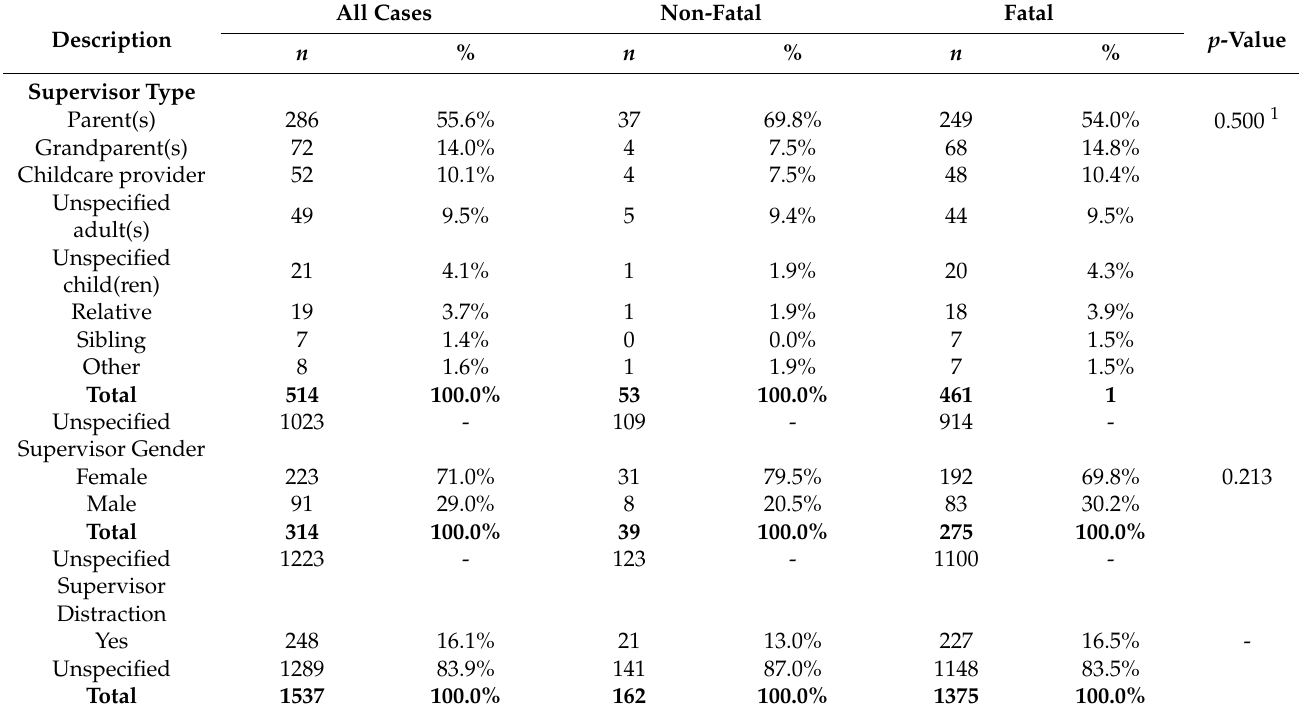
Table 4. Supervisor